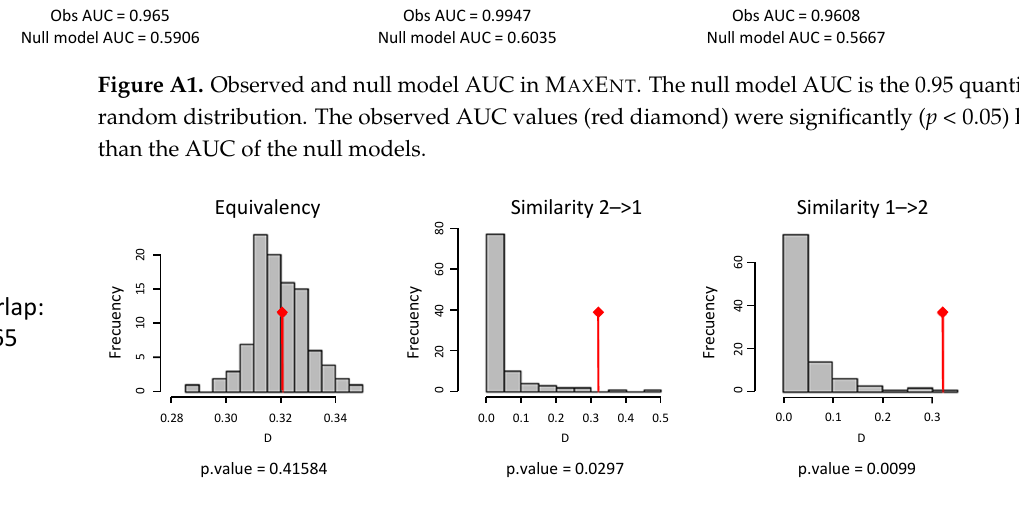
Figure A2. Niche overlap test. Histograms show the observed D -value (red diamond) versus the null distribution in the equivalence and similarity tests.